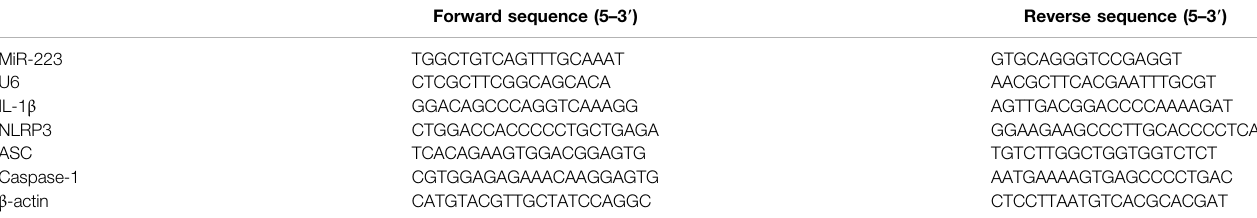
TABLE 1 | Real-time fl uorescent quantitative PCR primers.